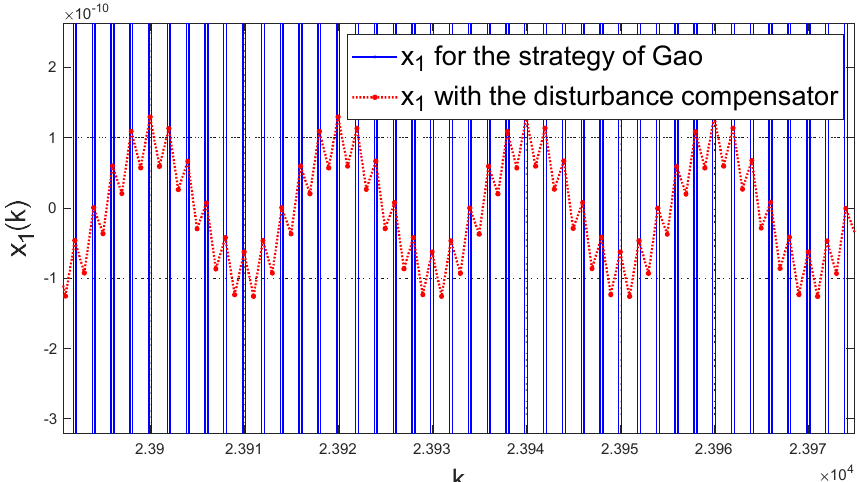
Figure 8. x 1 ( k ) for both control strategies in the sliding phase (zoomed).